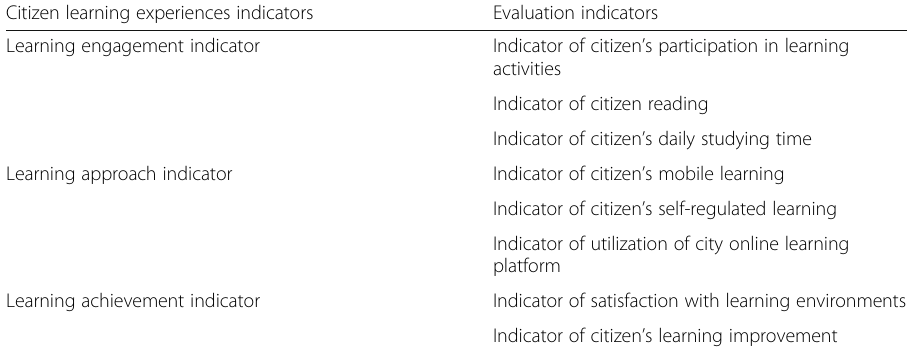
Table 1 Evaluation indicators of citizen experiences of smart learning Citizen learning experiences